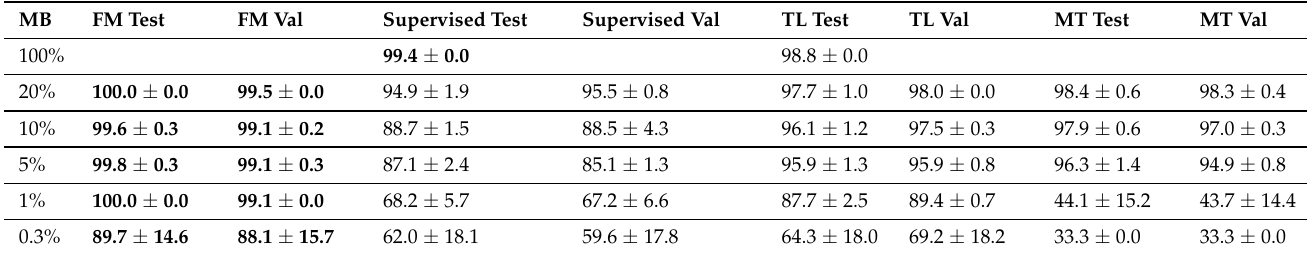
Table A1. Detailed results for MB dataset from Figure 4 with file-wise accuracy and standard deviation on test set (test) and unlabeled training set (val).